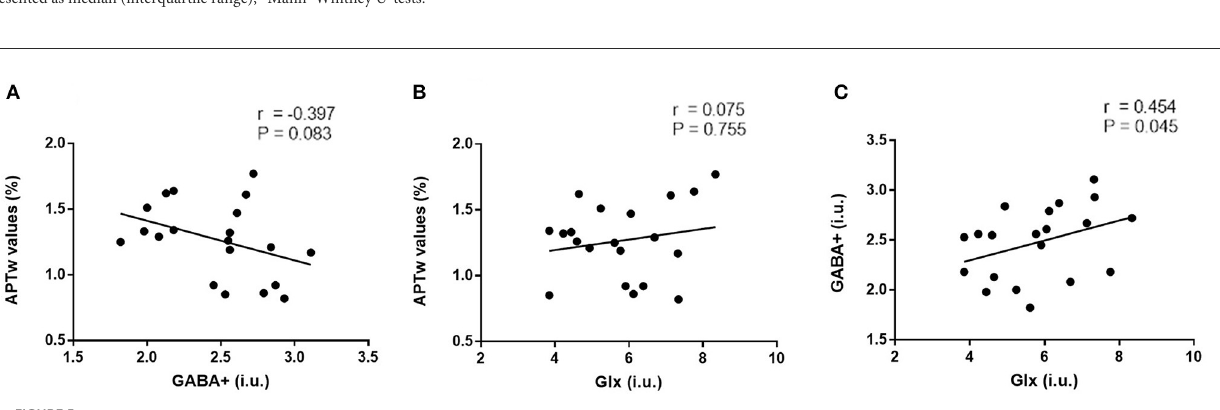
was 5.94 and − 2.78, respectively. Detailed comparison results are shown in Supplementary Table 1. The sensitivity and specificity of the combined markers were 0.7 and 0.95, respectively. The ROC curves are shown in Figure 6. The detailed diagnostic capability of univariate and multivariate variables is shown in Table